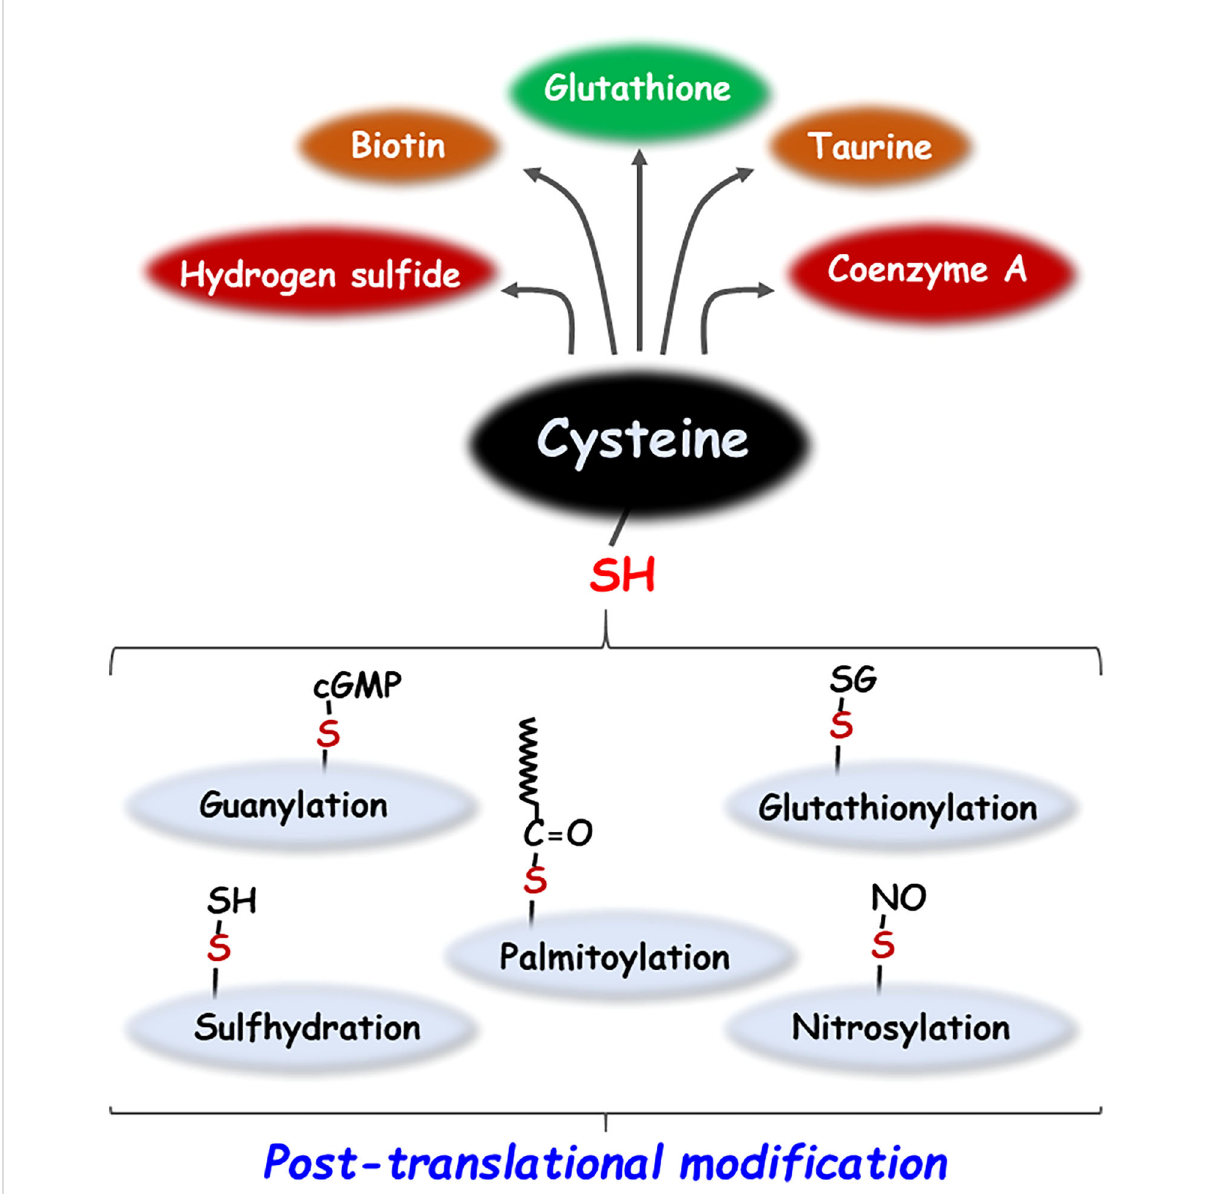
FIGURE 1 Metabolic products and post-translational modi fi cations of cysteine. Cysteine generates sulfur-containing molecules such as glutathione, taurine, biotin, coenzyme A and hydrogen sul fi de by various metabolic pathways. In addition, cysteine undergoes a variety of post-translational modi fi cations including palmitoylation, glutathionylation, guanylation, nitrosylation, and